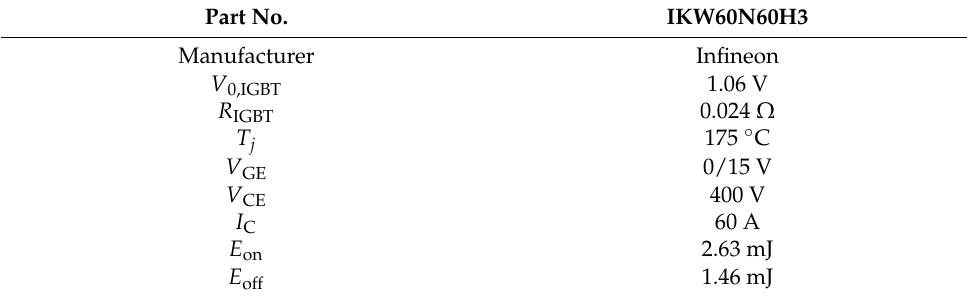
Table 2. IGBT key parameters.